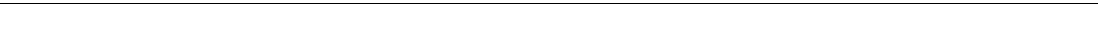
Figure 4. Percentage of Students Who Rated Certain Qualities as Important (top 2 out of 7 on the rating scale) ( N